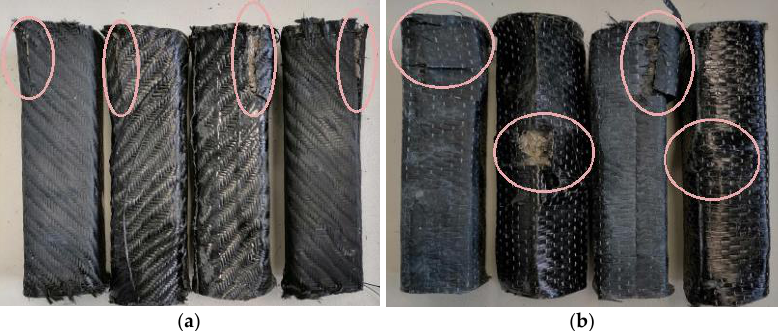
Figure 16. Compressed specimens reinforced with carbon fabric: ( a ) unidimensional fabric; ( b ) twill fabric.